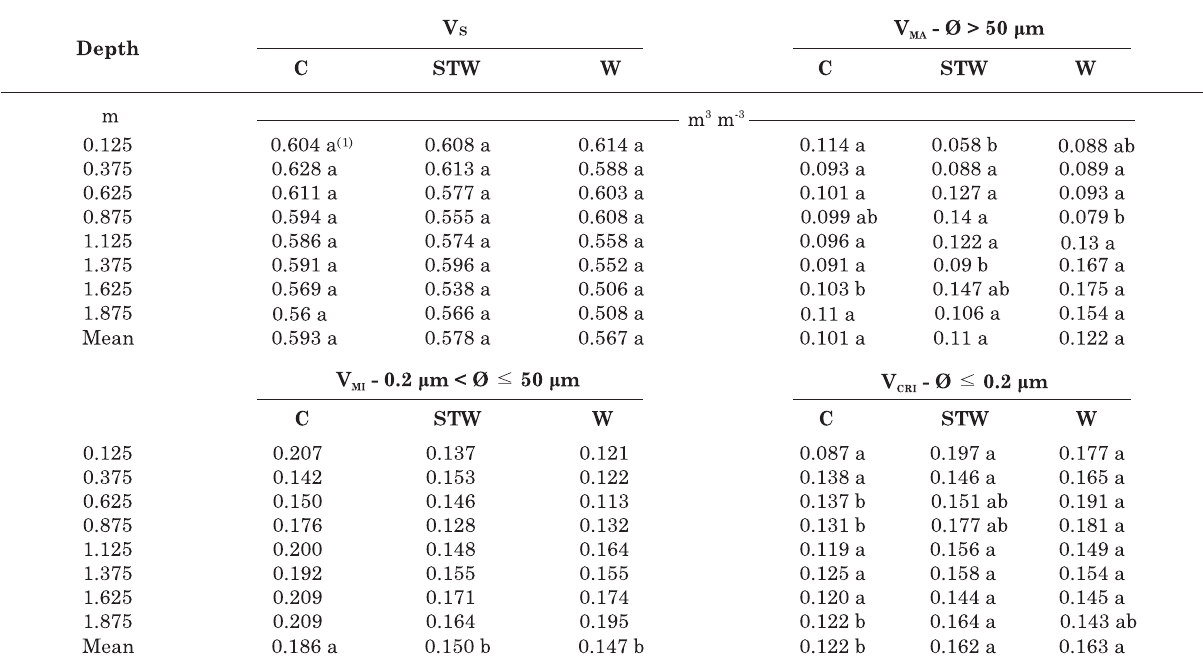
Table 4. Solids (V ), macropores (V S irrigated (STW) and water-irrigated (W)